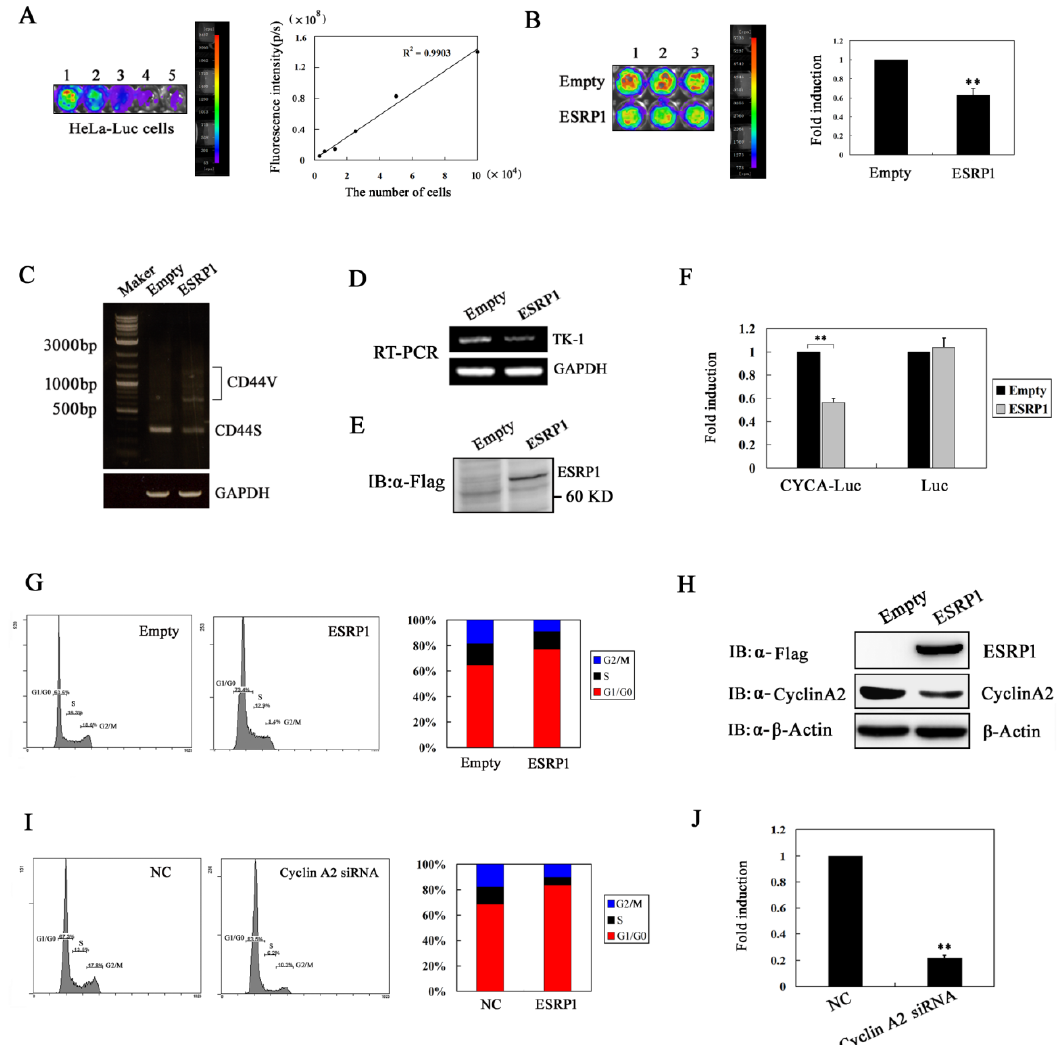
Figure 2. ESRP1 overexpression inhibits the proliferation of HeLa cells via inducing G1-phase arrest. ( A ) HeLa-Luc cells were serially diluted, placed into the wells of a 96-well plate, and immediately imaged using the NightOWL LB 983 system to obtain FLUX measurements per well. ( B ) HeLa-Luc cells were seeded into 96-well plates, and 48 h after transfection with pcDEF-FLAG-ESRP1(ESRP1) or a control vector (empty vector) (0.2 μg/well), FLUX measurements were captured (left). For normalization of luciferase activity, the luciferase signal per well of the control cells was set to 1. Quantitative data represent the mean ± standard error ( n = 3 per group) (right). HeLa cells were seeded into 6-well plates, and 48 h after transfection with ESRP1 or a control vector (2 μg/well), CD44 isoforms ( C ) or TK-1 expression ( D ) was measured via RT-PCR in HeLa cells following overexpression of ESRP1, with GAPDH as a control. ESRP1 levels in HeLa cells were measured via Western blotting, with empty vectors serving as negative controls ( E ). ( F ) 48 h after ESRP1 vector or empty transfection, HeLa-CYCA-Luc or HeLa-Luc cells were lysed, and luciferase activity was assessed. ( G ) The cell cycle distribution in ESRP1-overexpressing HeLa cells and empty control groups was assessed via flow cytometry, revealing G1-phase arrest in HeLa cells 48 h after transfection with ESRP1 vector. ( H ) ESRP1 or cyclin A2 levels in HeLa cells as measured by Western blotting. 48 h after treatment with 50 nM cyclin A2 siRNA for 48 h, HeLa-CYCA-Luc cells were analyzed via flow cytometry ( I ), or lysed and luciferase activity was assessed ( J ). For normalization of CYCA-Luc activity or Luc, the signal (1 μg protein) for control cells was set to 1. This experiment was repeated three times ( n = 3); error bars indicate standard error; ** p < 0.01.